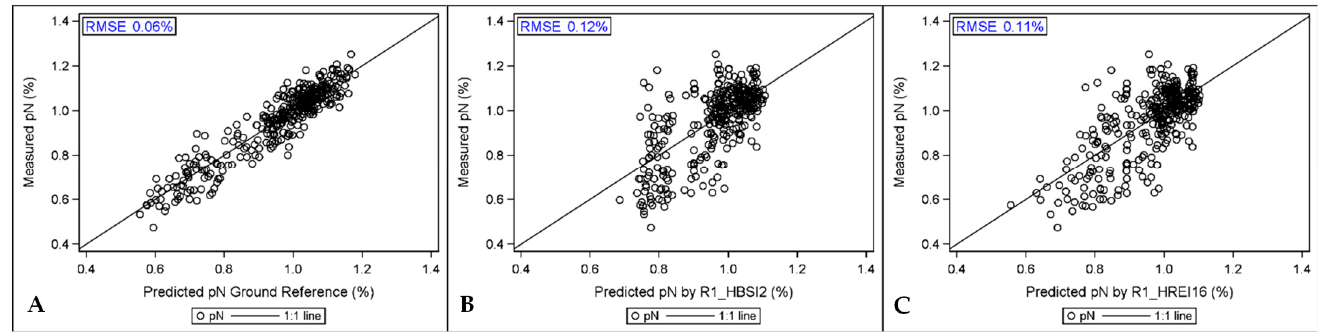
Figure 3. Least square means estimates of N concentration (pN) (%) by hybrid for the ground reference model, HBSI2 and HREI16 at R1 models.